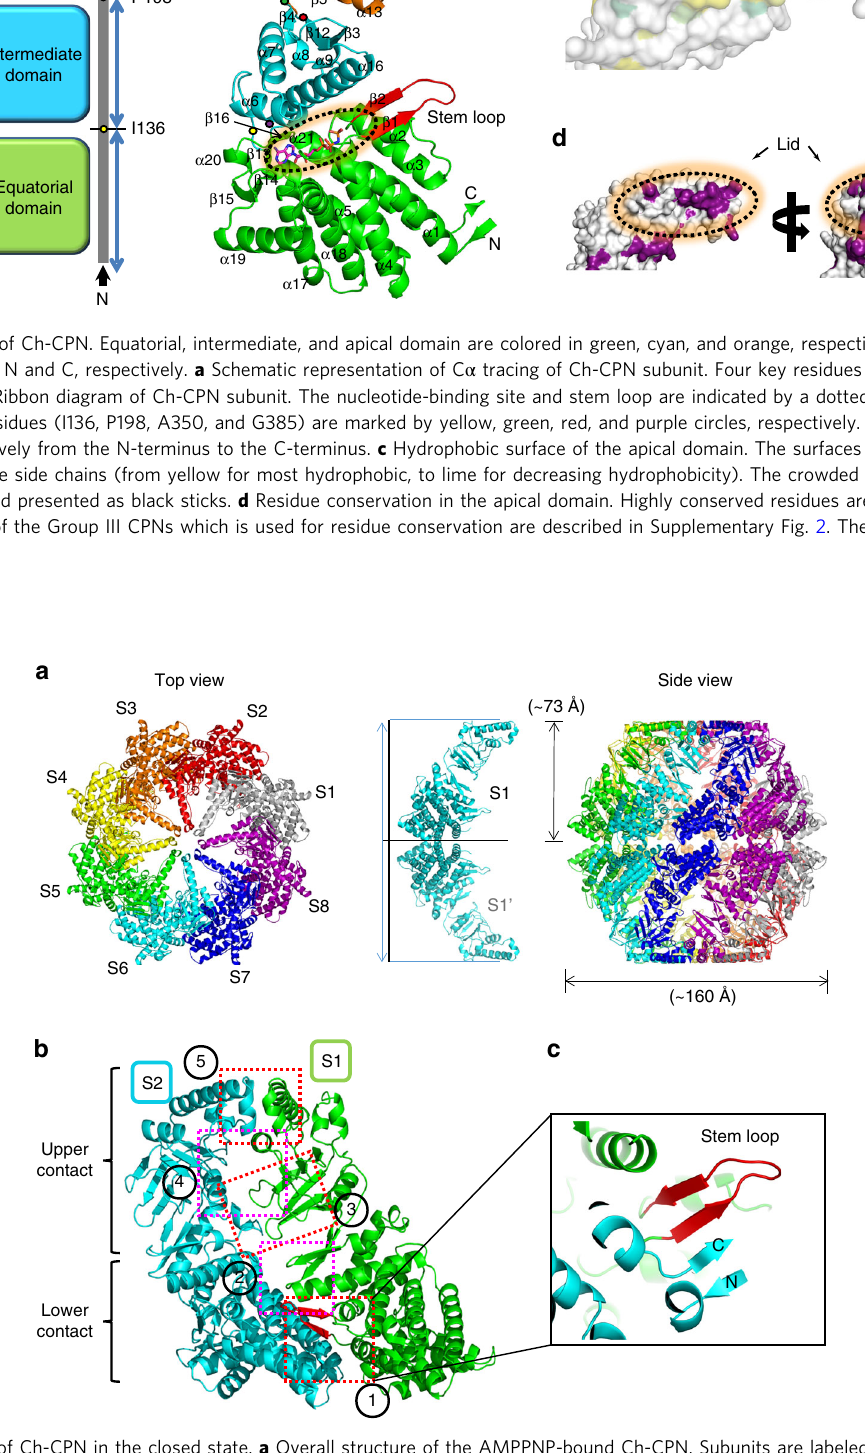
Fig. 2 Crystal structure of Ch-CPN in the closed state. a Overall structure of the AMPPNP-bound Ch-CPN. Subunits are labeled as S1 – S8 and shown in different colors. The conformation of an inter-ring dimer (S1 and S1 ′ ) is depicted to calculate the molecular dimension (middle). b Contact areas in the intra ring dimer (S1 and S2). Interactions of adjacent subunits are indicated by dotted boxes. c Close-up view of the inter-subunit β -sheet in the closed state. Details of other interactions (from 2 to 5) are included in Supplementary Fig. 3